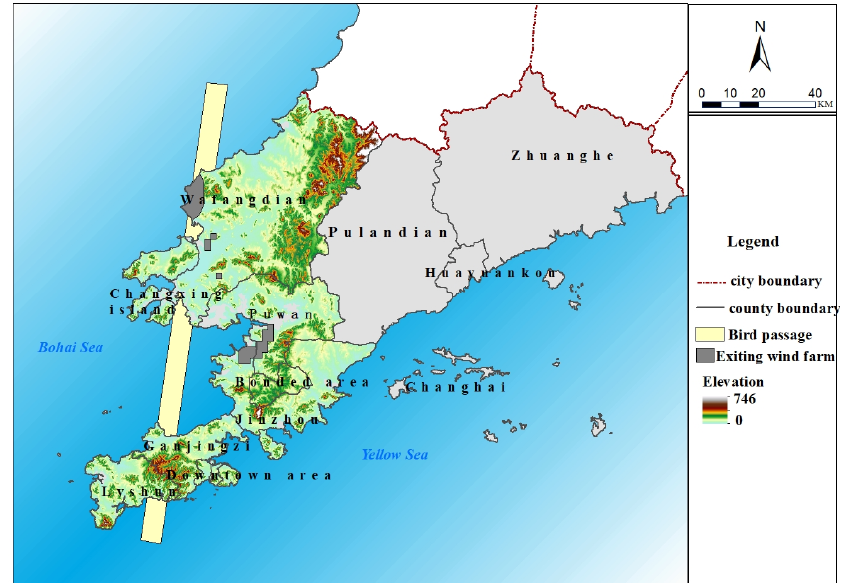
Figure 5. Existing wind farm in the study area.